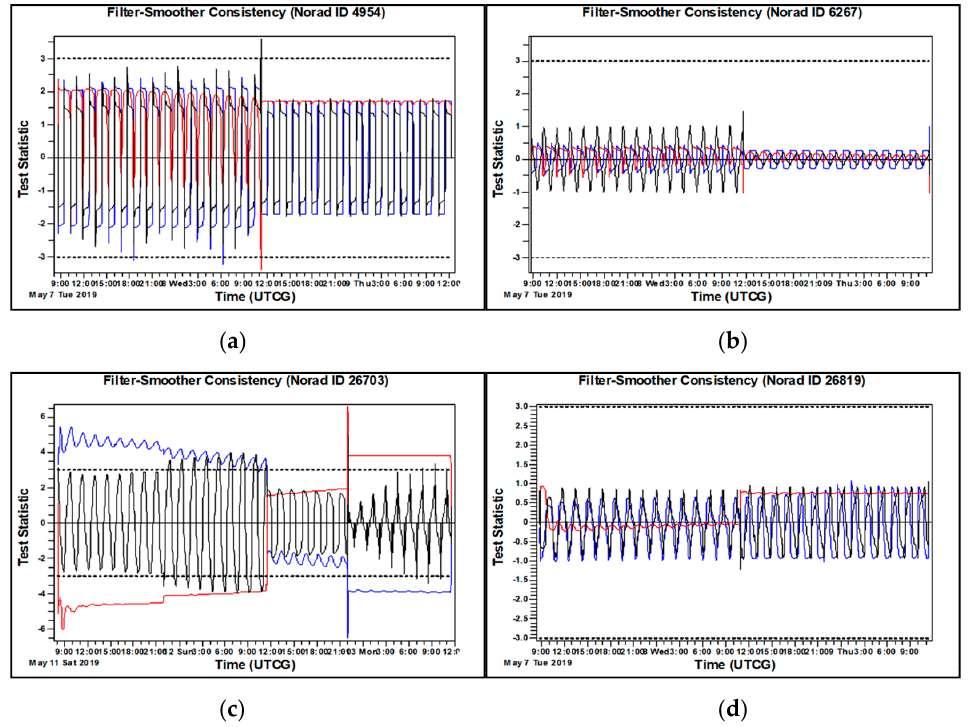
Figure 5. The FS consistency of tracking data, the blue, red and black line represent the radial, in-track and cross-track, respectively. ( a ) ID 4954; ( b ) ID 6276; ( c ) ID 26703; ( d ) ID 26819.